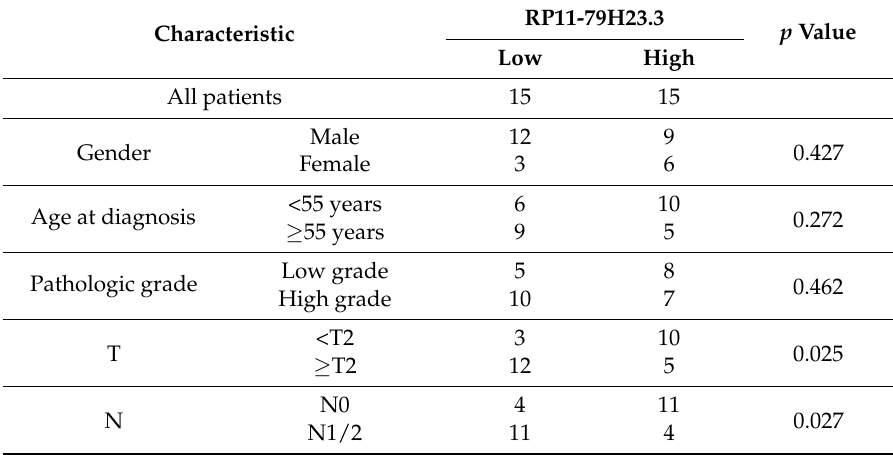
p Value 0.427 0.272 ≥